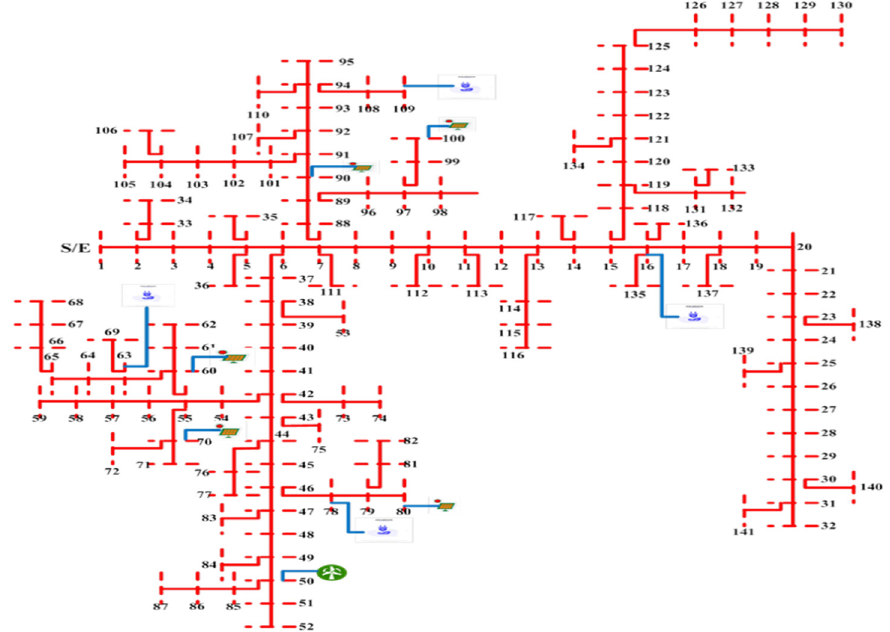
Figure 5. Second MG configuration.